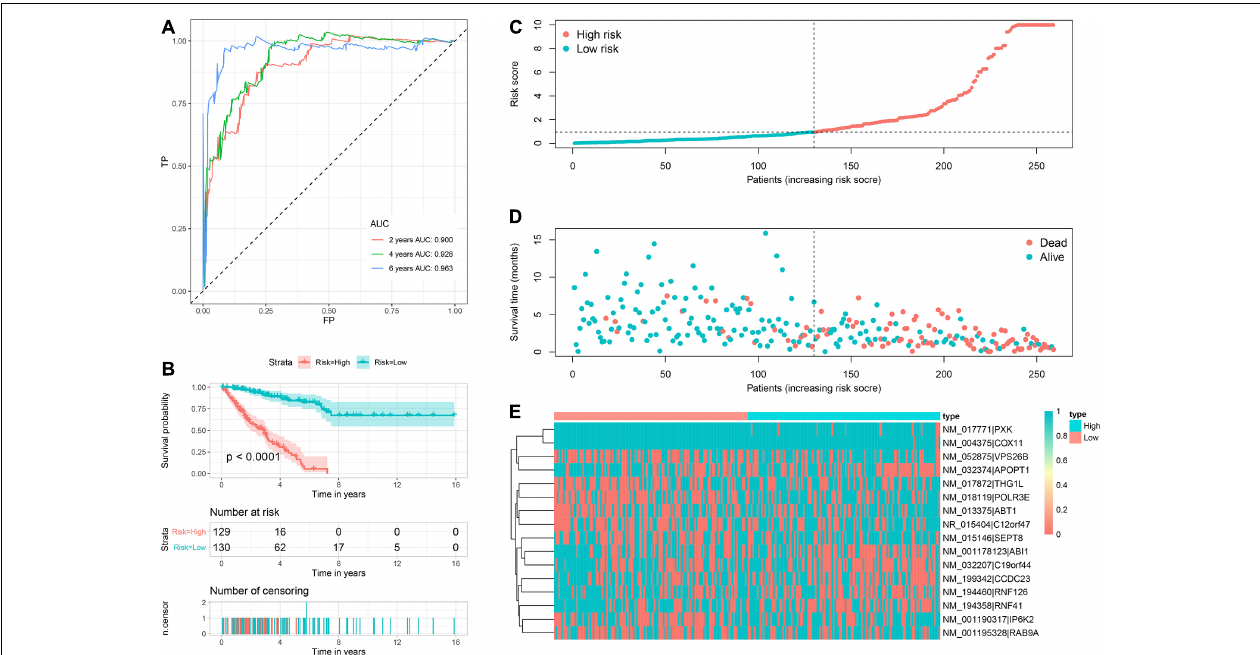
FIGURE 3 | Prognostic signature to predict OS of sarcoma patients. (A) ROC curves of OS signature. (B) Survival curve showed that high-risk patients were worse OS than low-risk patients. (C) Risk score distribution of 259 sarcoma patients. (D) OS status of 259 sarcoma patients. (E) Heatmap showed the distribution of PDUI of 16 OS-related APA events in low- and high-risk patients. OS, overall survival; ROC, receiver operating characteristic; APA, alternative polyadenylation.